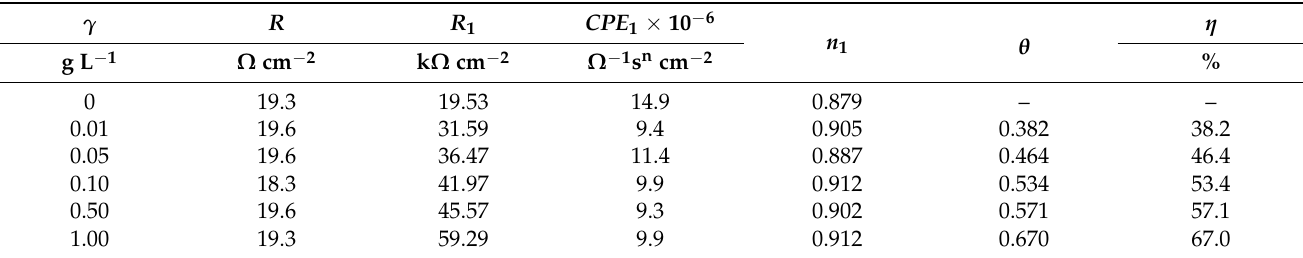
Table 3. Impedance parameters of Al 5083 alloy in ASW without and with the addition of different concentrations of Artemisia annua L. extract (AAE).